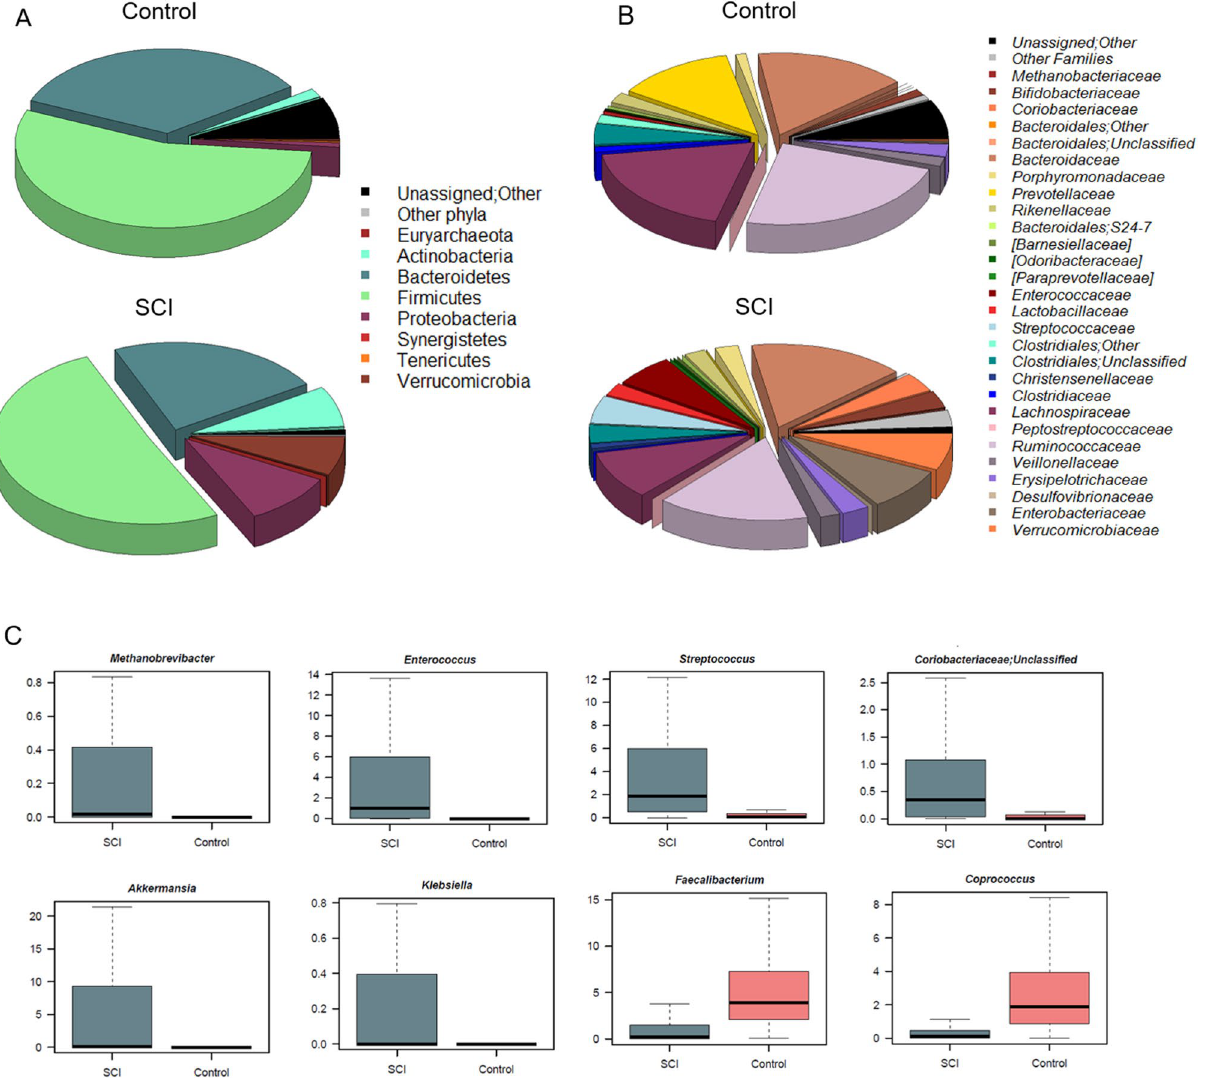
Figure 2. Compositional structure of the gut microbiota in SCI. Pie charts showing the average relative abundance of the most abundant phyla ( A ) and families ( B ) in SCI patients as compared to age- and sex- matched healthy Italian controls. Only taxa with relative abundance > 0.1% in at least 20 samples for phyla and > 0.01% in at least 30 samples for families are shown. ( C ) Box plots showing the distribution of the relative abundance values of discriminant genera between SCI patients and healthy controls, according to Random Forests. p < 0.001, Wilcoxon rank sum